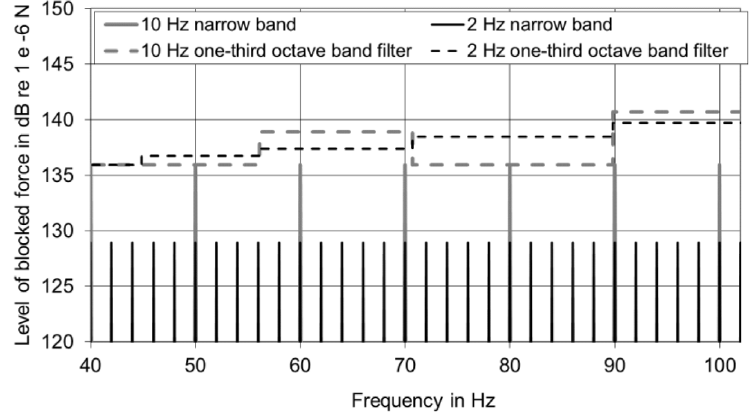
Figure 8. Visualisation of Equation (6) in combination with Table 1 showing the summation of spectral lines to one-third octave bands for the theoretical assumptions of a 10 Hz line spectrum and a 2 Hz line spectrum, plastic impact ( v 0